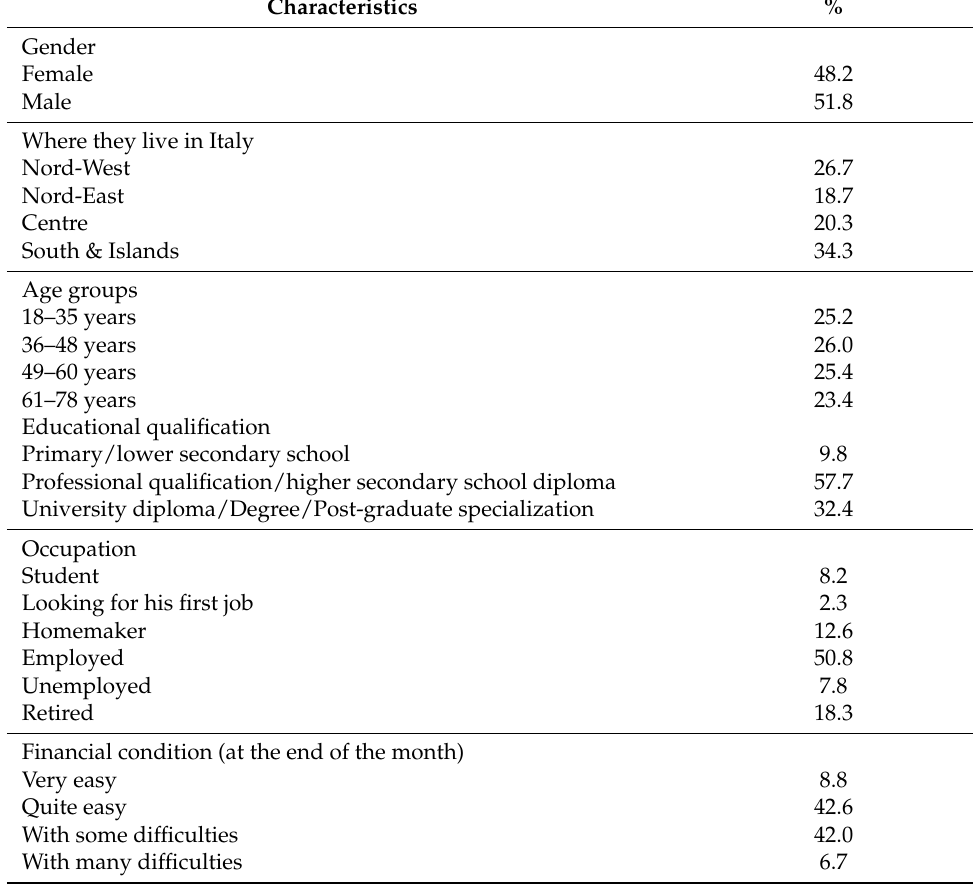
Table 3. Socio-demographic characteristics of the consumers of rabbit meat (%, n = 705). Characteristics %